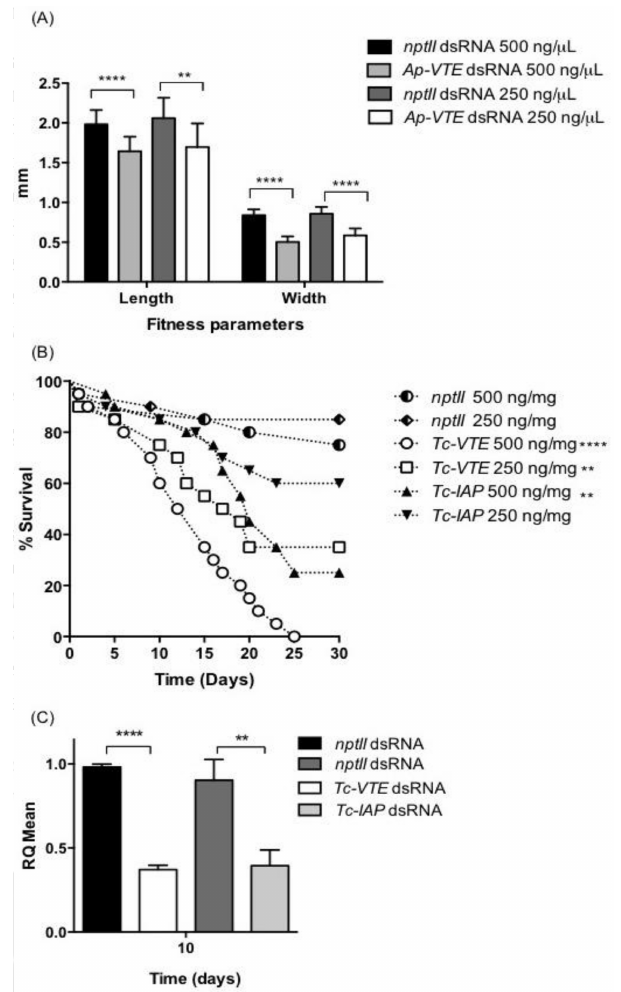
Figure 5. Oral delivery of dsRNAs. ( A ) Length and width of A. pisum 10 days after feeding on dsRNA containing diets. Asterisks depict significant differences **** p < 0.0001 and ** p < 0.01 relative to control treatments; ( B ) Survival of T. castaneum after feeding 1st–2nd instar larvae on flour discs containing Tc-VTE and Tc-th dsRNAs ( n = 20 per treatment) for 30 days. Asterisks depict significant differences **** p < 0.0001 and ** p < 0.002 relative to control treatments; ( C ) Relative expression of Tc-VTE and Tc-th mRNAs in T. castaneum larvae after 10 days after feeding on flour discs containing dsRNAs (500 ng/mg diet). Error bars indicate the ± SD of the mean from three independent biological replicates ( n = 5 insects per treatment), each with three technical replicates. RQ set to 1.0 for nptII control 10-day biological replicate 1. Asterisks depict significant differences **** p < 0.0001 and ** p = 0.0047 relative to control